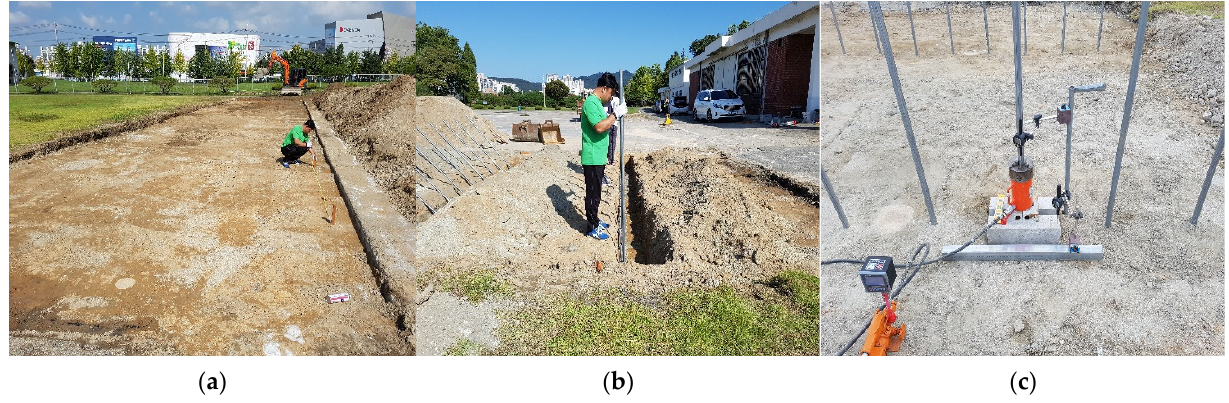
Figure 4. Field test procedure of site A: ( a ) ground grading work; ( b ) embedded depth leveling; ( c ) uplift testing of continuous foundations.